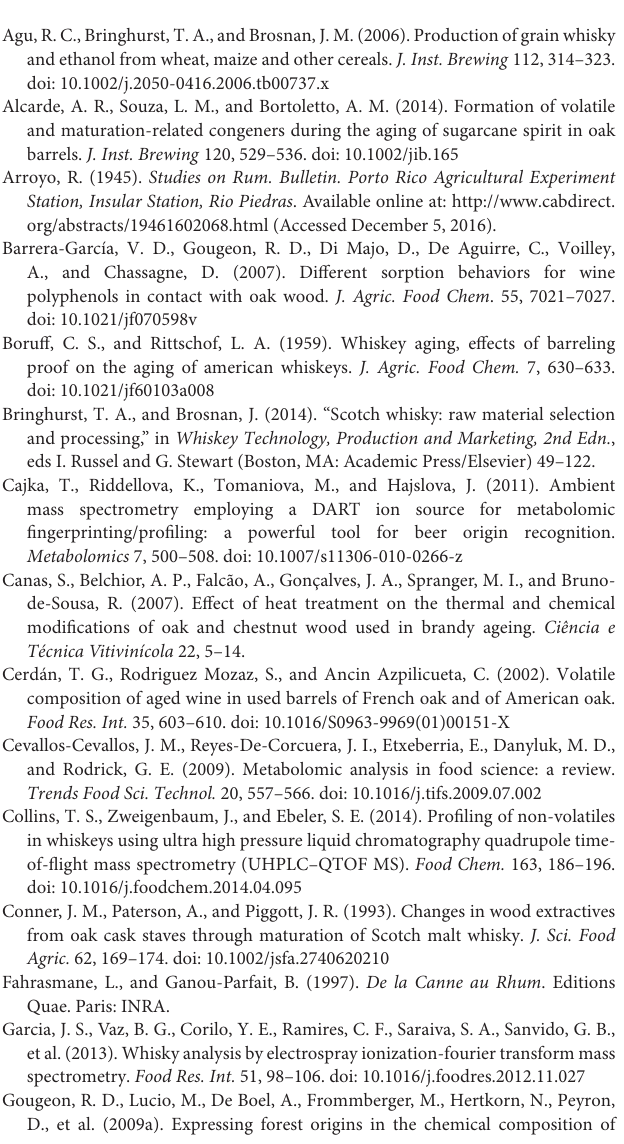
Supplemental Figure 1 | Evaluation of the repeatability of FT-ICR-MS analysis overtime. Comparison of spectra between m/z 100 and 600 Da and at nominal